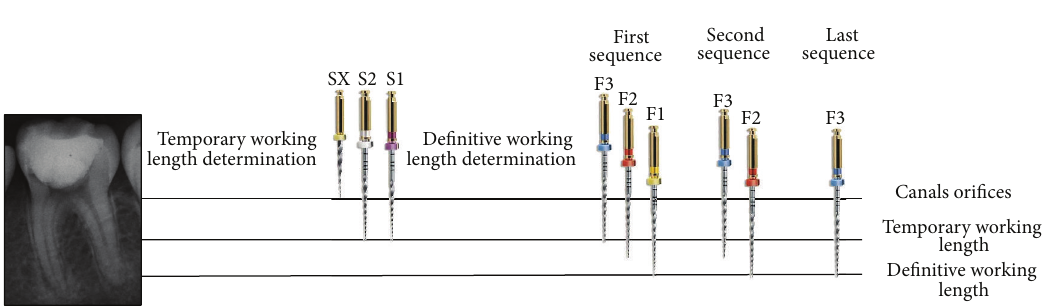
Figure 2: Sequence showing a different protocol for using Protaper